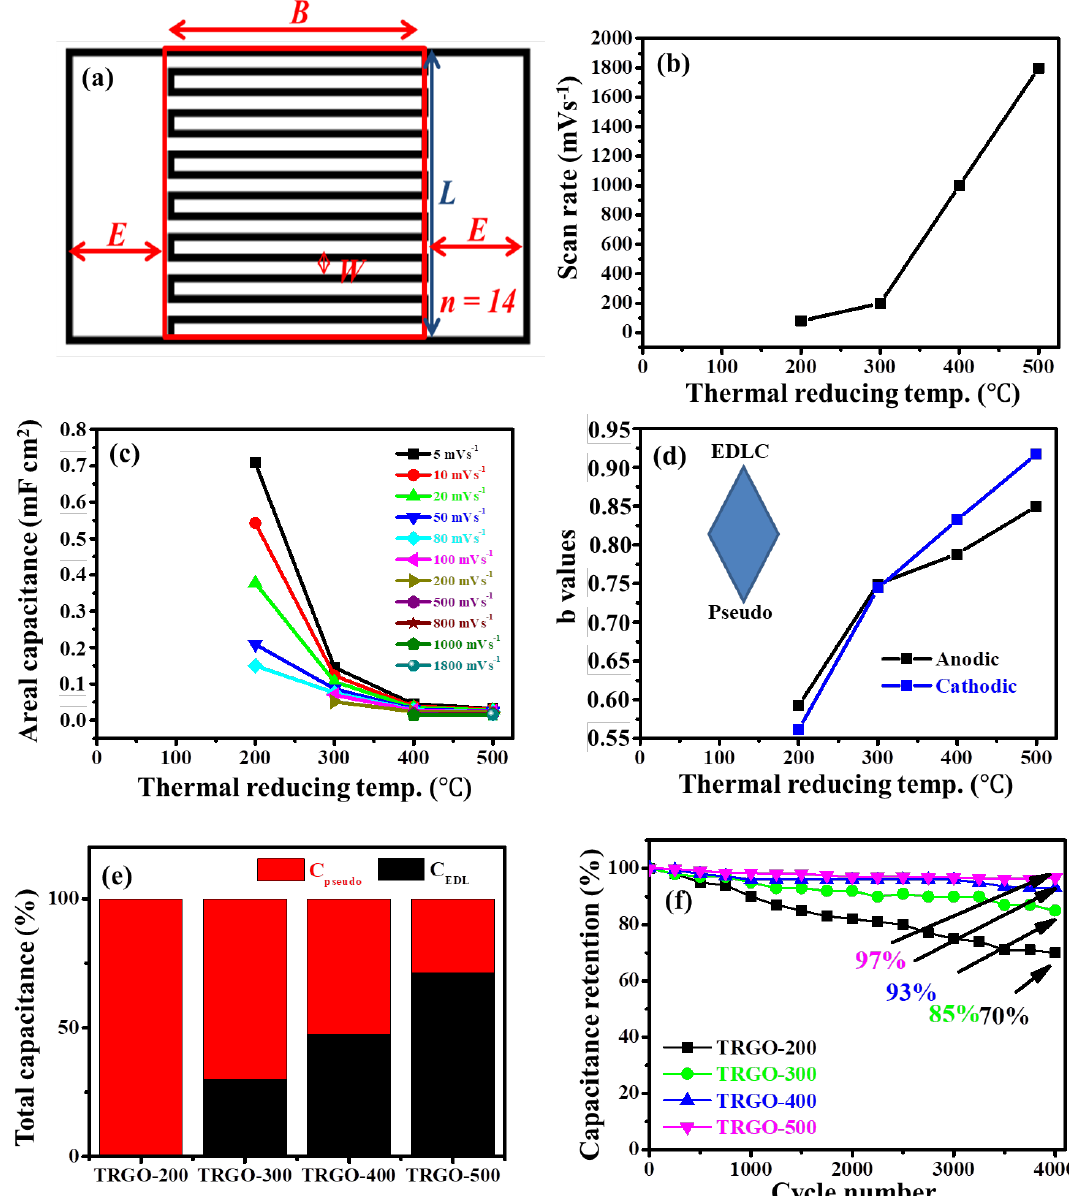
Figure 8. ( a ) µ -SC schematic, ( b ) scan rate, ( c ) areal capacitance, ( d ) b values versus RT, ( e ) Trasatti analysis capacitive contribution, and ( f ) capacitance retention as a function of cycle number of TRGO samples.